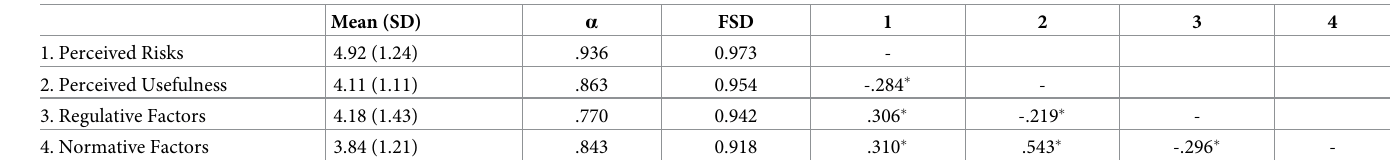
Table 3. Scores, reliability and correlations among factors §